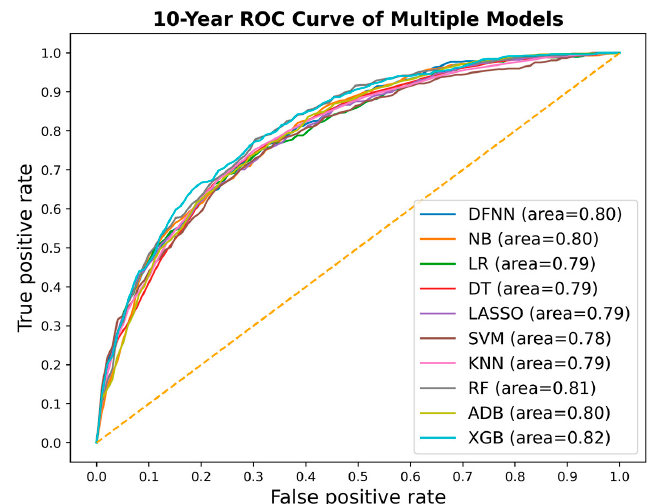
Figure 3. ROC curves of the best-performing models for all methods, each respectively, for predict-